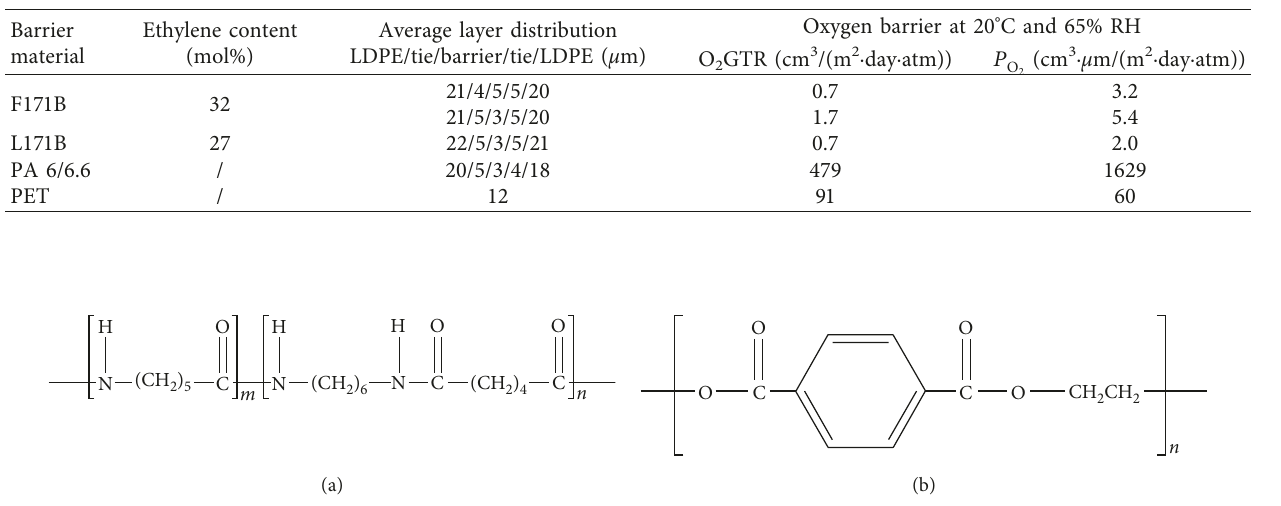
Table 1: Film samples and their